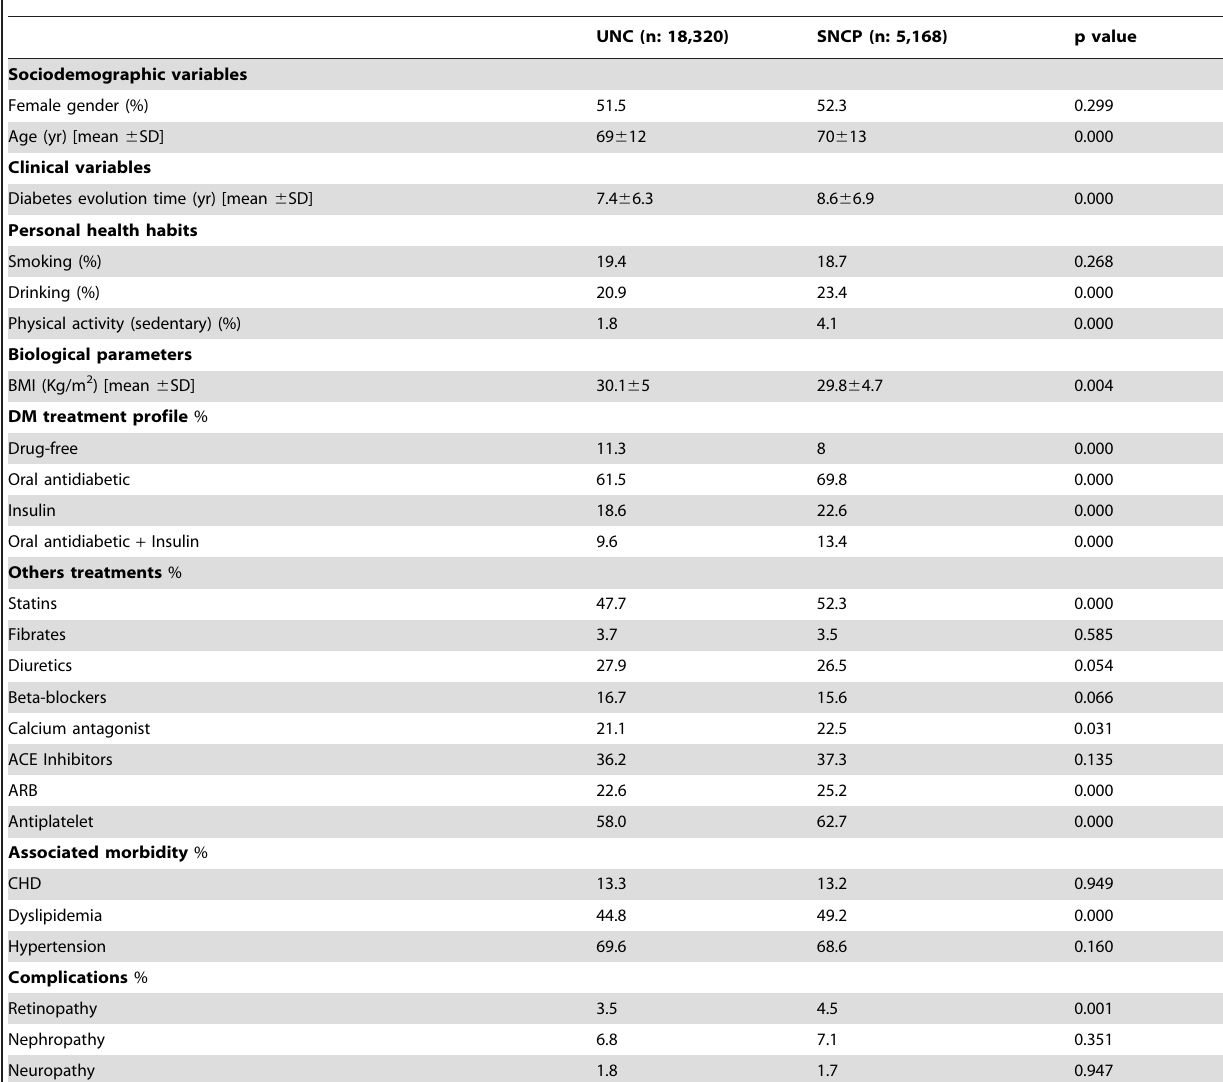
Table 3. Baseline characteristics of the study